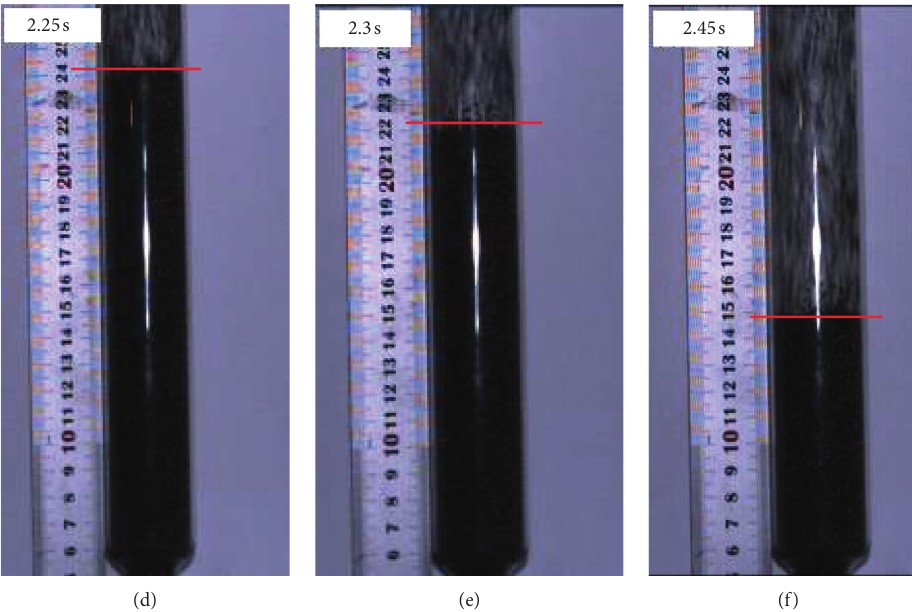
Figure 6: Experiment flow snapshots were taken with a high-speed camera: (a–d) interface between dilute flow and dense flow rose with time. (d–f) interface declined with time. (a) and (f) the lowest location of the interface. (d) The highest location of the interface. (b), (c), and (e) the middle location of interface at different time.